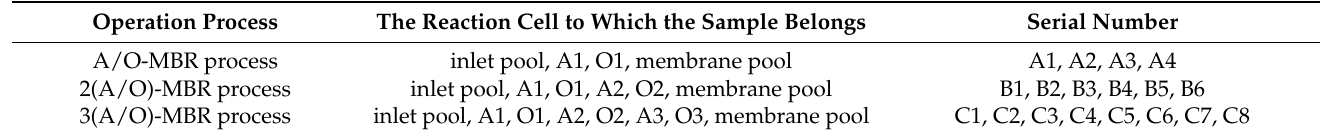
Table 2. Microbiological sample number.